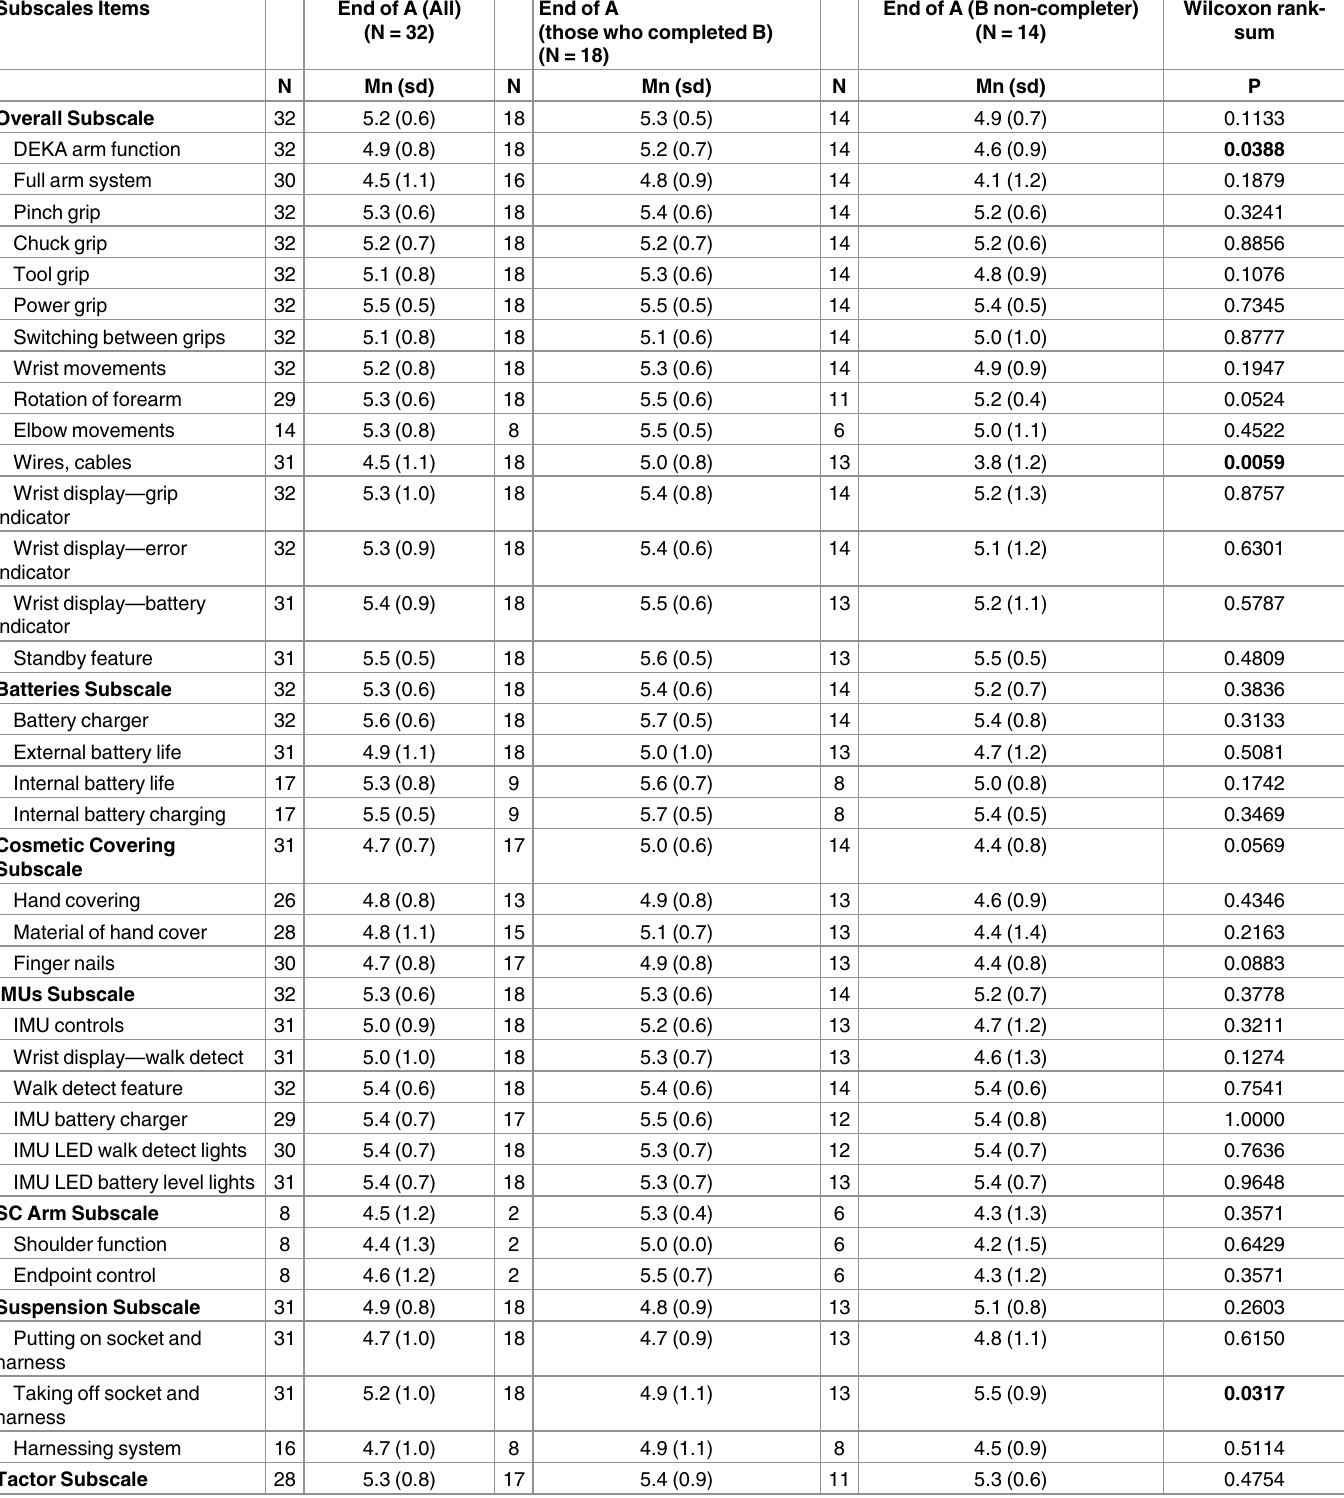
Table 5. Ease of Use subscales and item scores for participants who completed only Part A and those who completed Part A and Part